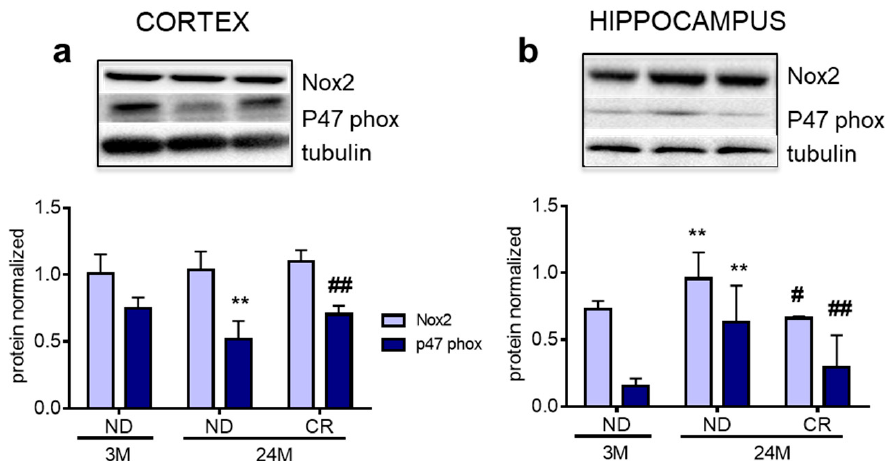
Figure 5 . Impact of age and CR on Nox2 and p47phox proteins in rat cortex and hippocampus. Representative Western blots and densitometric analyses of Nox2 and p47phox levels in the cortex ( a ) and hippocampus ( b ). Tubulin served as housekeeping protein to normalize protein loading. 3M (3-month-old rats); 24M (24-month-old rats); ND (normal diet); CR (caloric intake reduced by 40% for the last 6 months of life). Statistical analysis was performed by using one-way ANOVA followed by Tukey’s post hoc test. ** p < 0.01 vs. 3M ND, # p < 0.05; ## p < 0.01 vs. 24M ND. We further studied the level of synaptotagmin, a marker of synapses [31]. The result in the cortex or hippocampus.